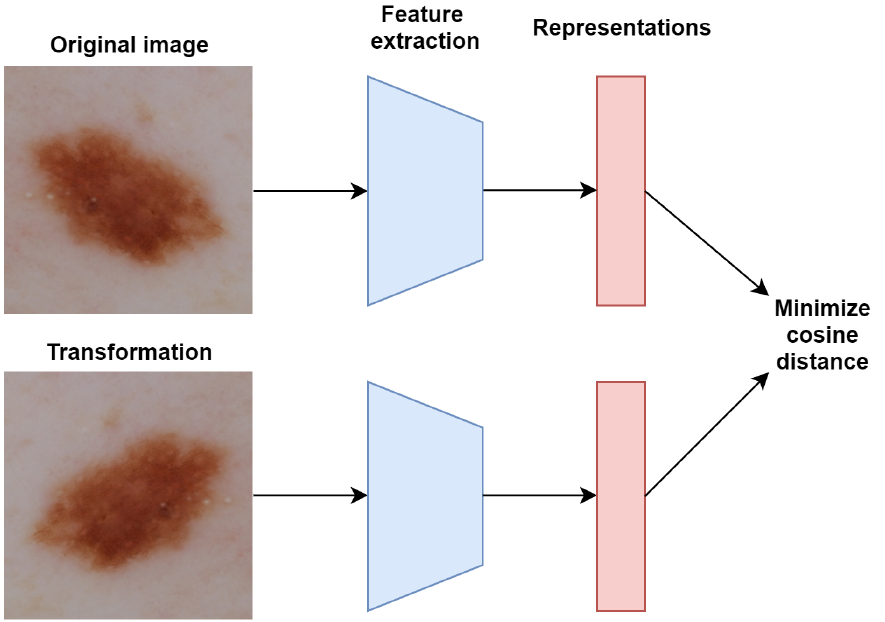
Figure 4. Rotation pretext task